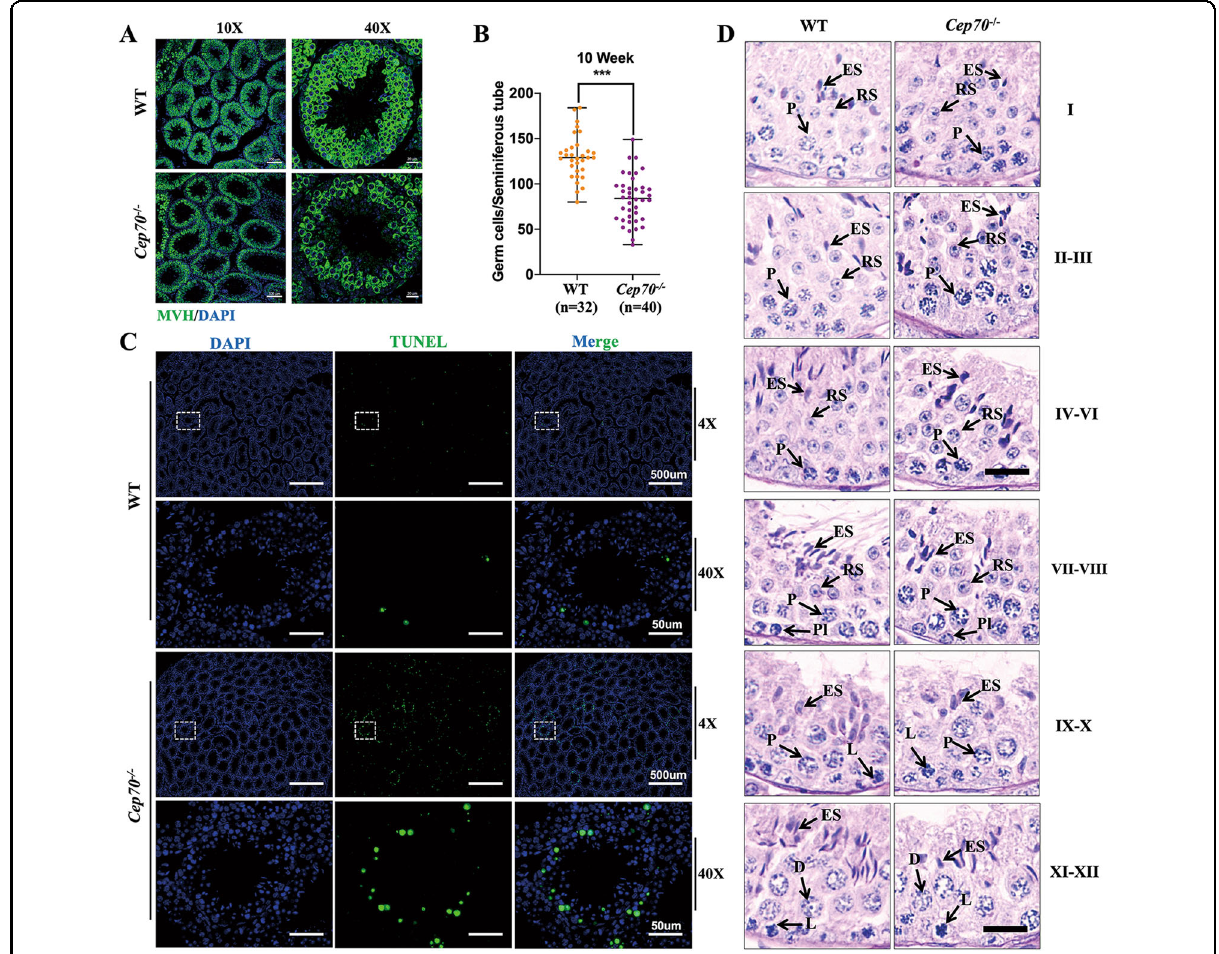
sections of the WT and Cep70 − / − mice, demonstrating a signi fi cant decrease of germ cells in the seminiferous tubules of Cep70 − / − mice. Scale